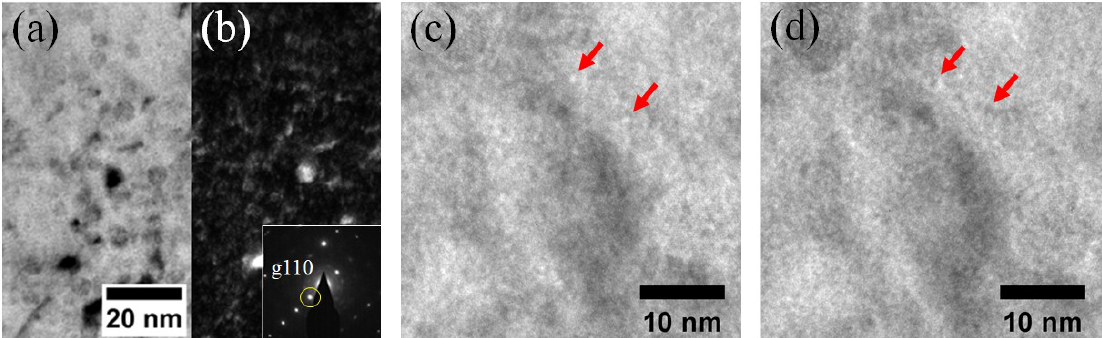
Figure 3. ( a ) Bright-field, ( b ) dark-field, ( c ) under-focused, and ( d ) over-focused TEM images taken from 300–400 nm depth region, after 1 × 10 15 He ions/cm 2 implantation. The diffraction pattern used to obtain BF and DF images is superimposed on ( b ) with g110 indexed. He bubbles appear bright and dark in under-focused and over-focused images, respectively.